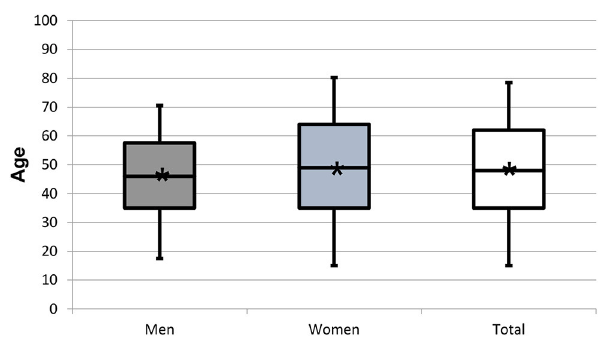
FIGURE 3 | Box plots representing the age distribution by gender of the 682 patients who did not complete the WISE or did not consent to data use. Star symbol (*) indicates mean.